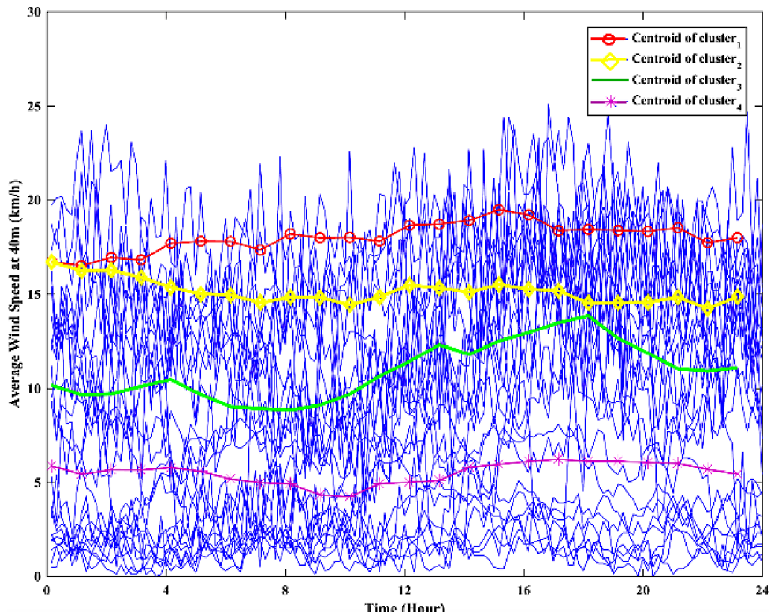
Figure 12. Cluster centers versus dataset [15].